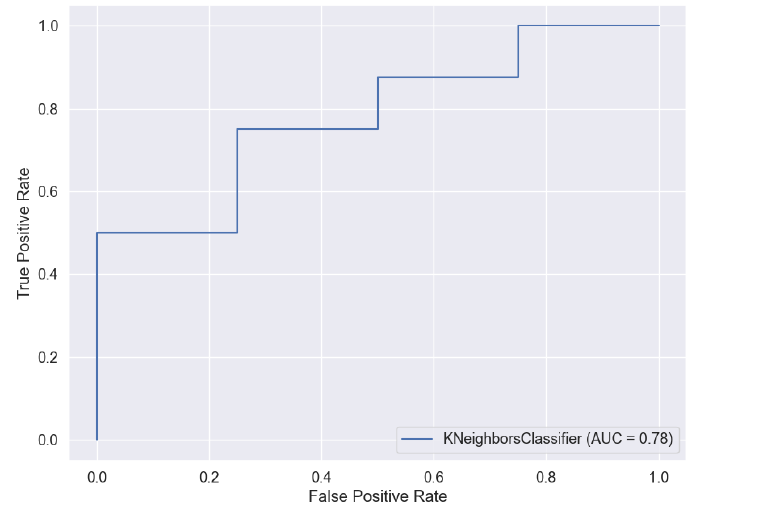
Figure 6. ROC curve from kNN binary classification (PPA vs. CG) model.